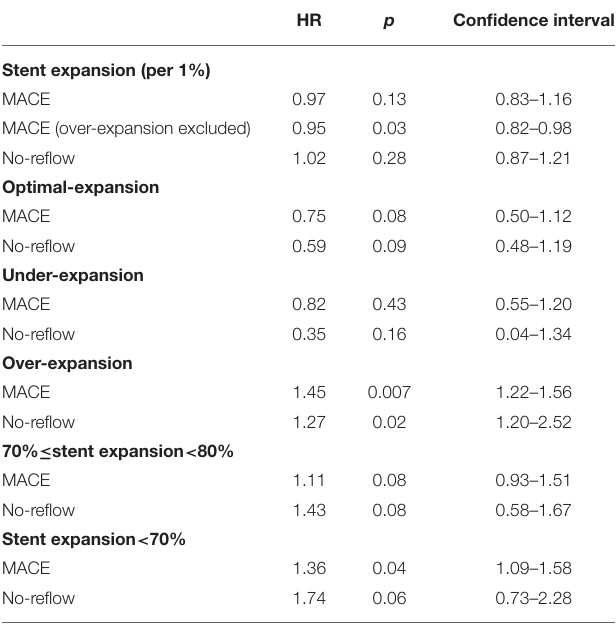
TABLE 5 | Multivariate cox survival regression analyses of stent expansion for prognosis. HR p Confidence interval